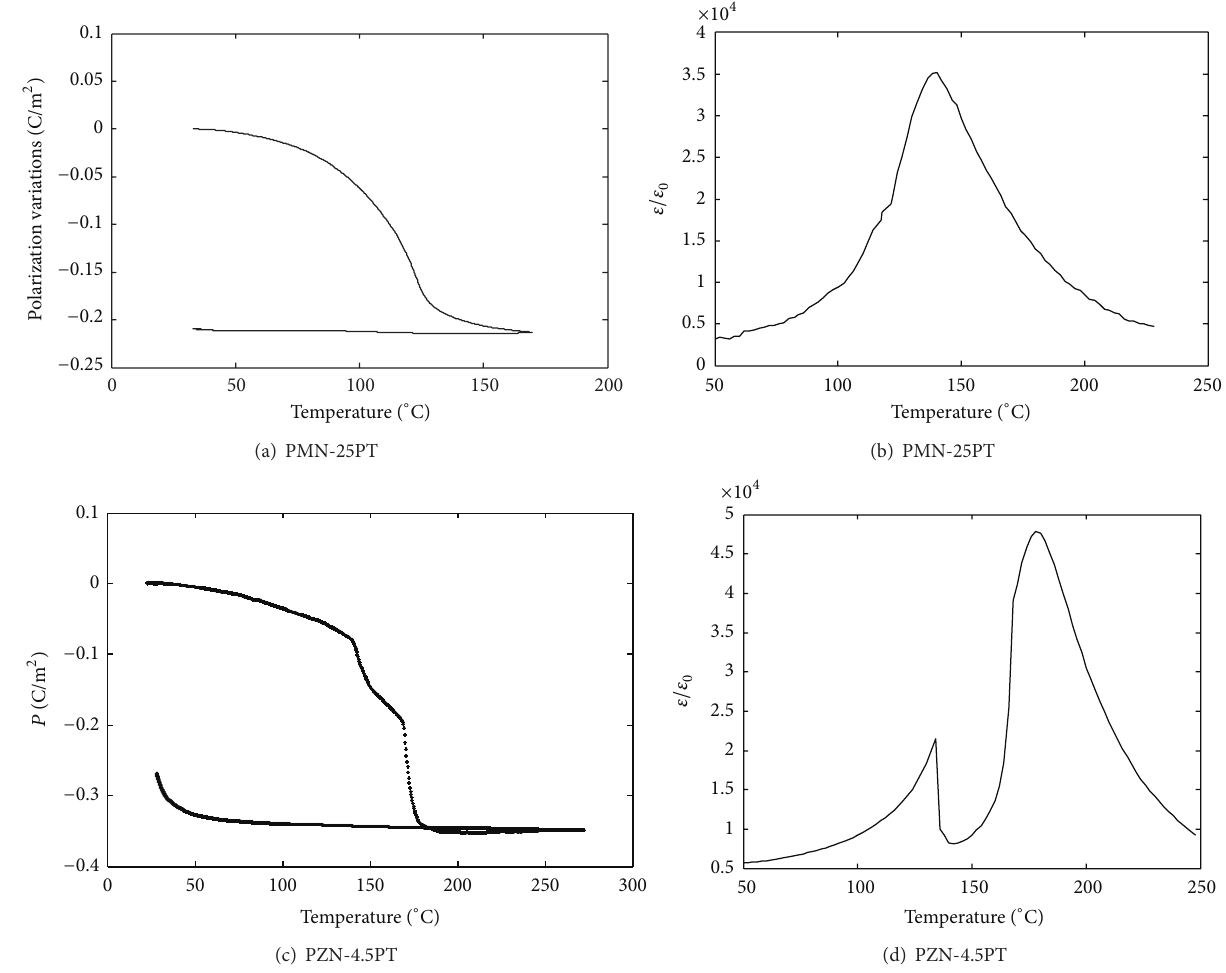
Figure 3: Temperature dependence of the polarization and dielectric